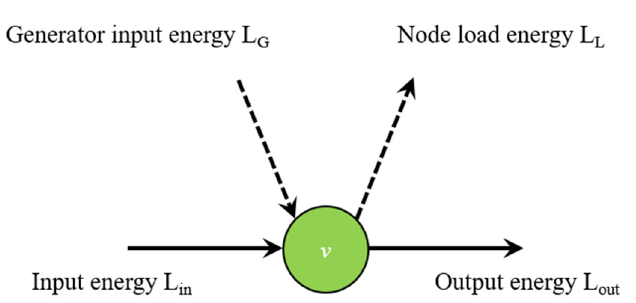
Figure 9. Schematic diagram of energy flowing through nodes.